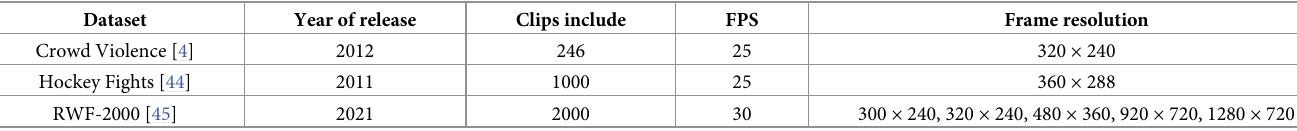
Table 2. Introduction of used datasets for violence recognition.